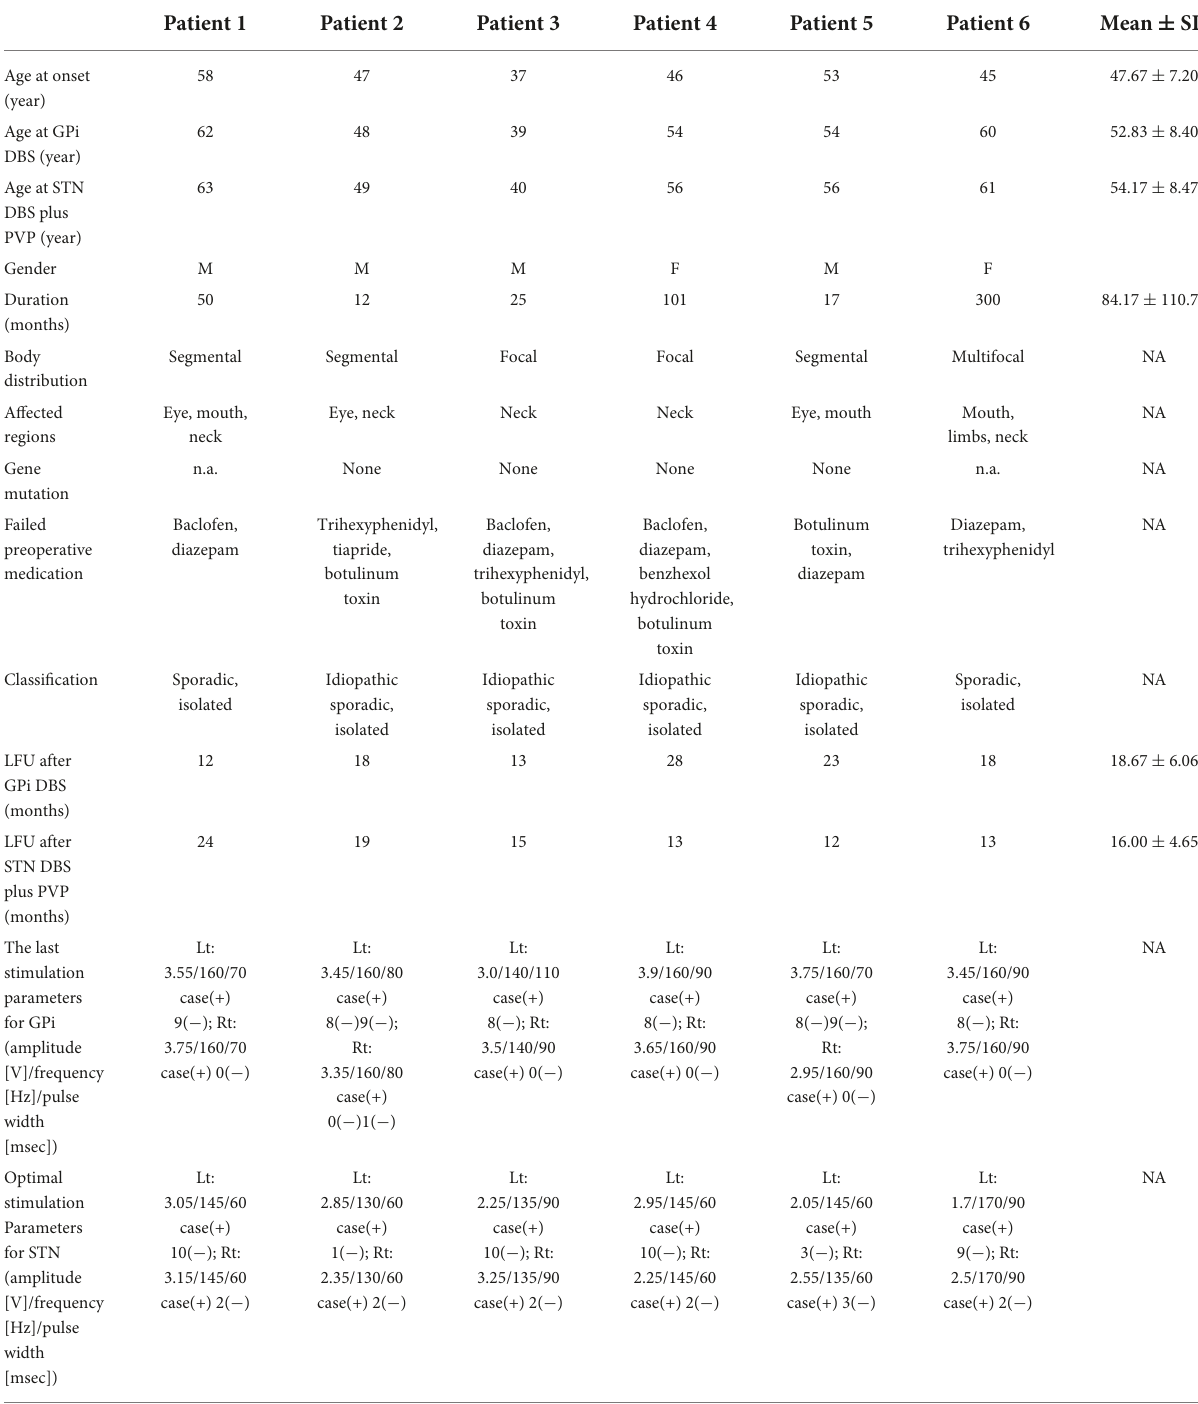
TABLE 1 Clinical characteristics and clinical outcomes for each patient.